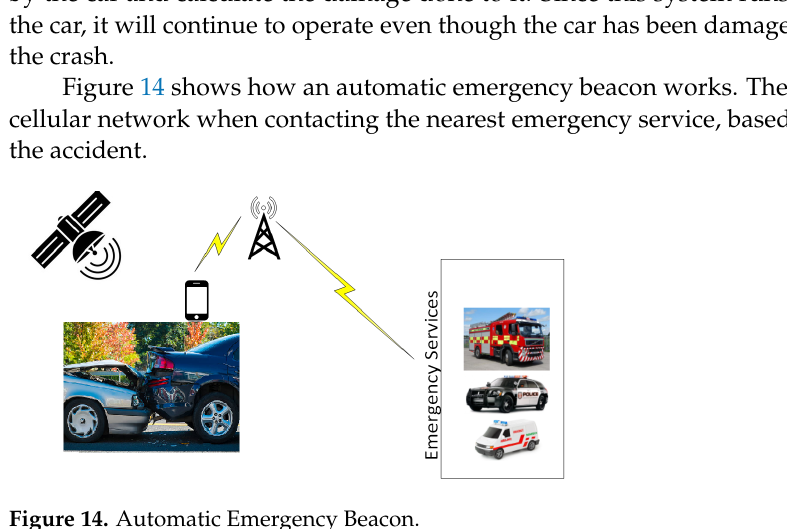
Figure 14. Automatic Emergency Beacon.